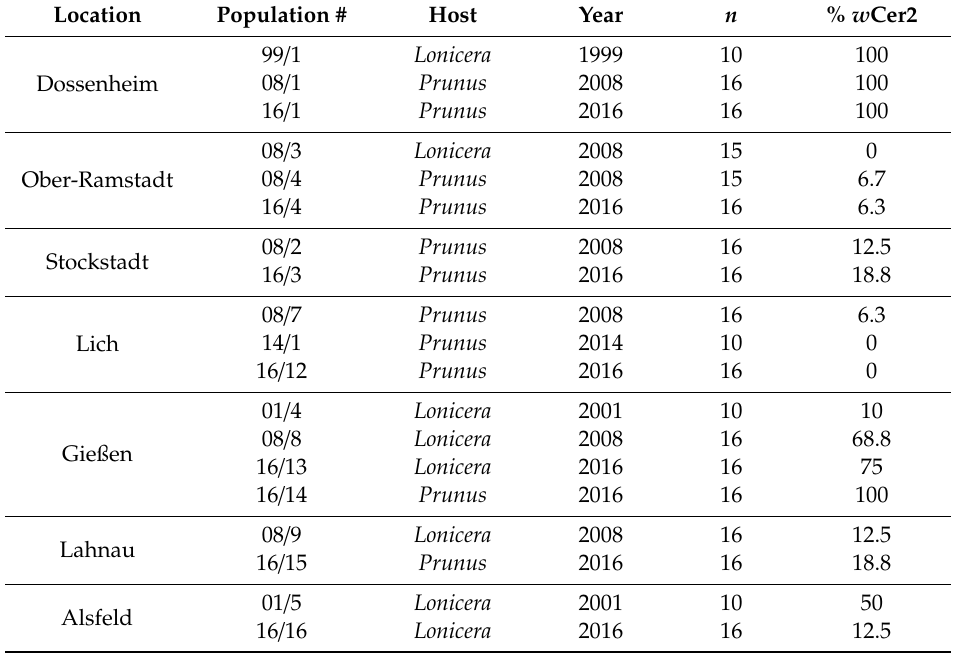
Table 2. Comparison of w Cer2 infection frequencies among the years 1999 (99), 2001 (01), 2008 (08), and 2016